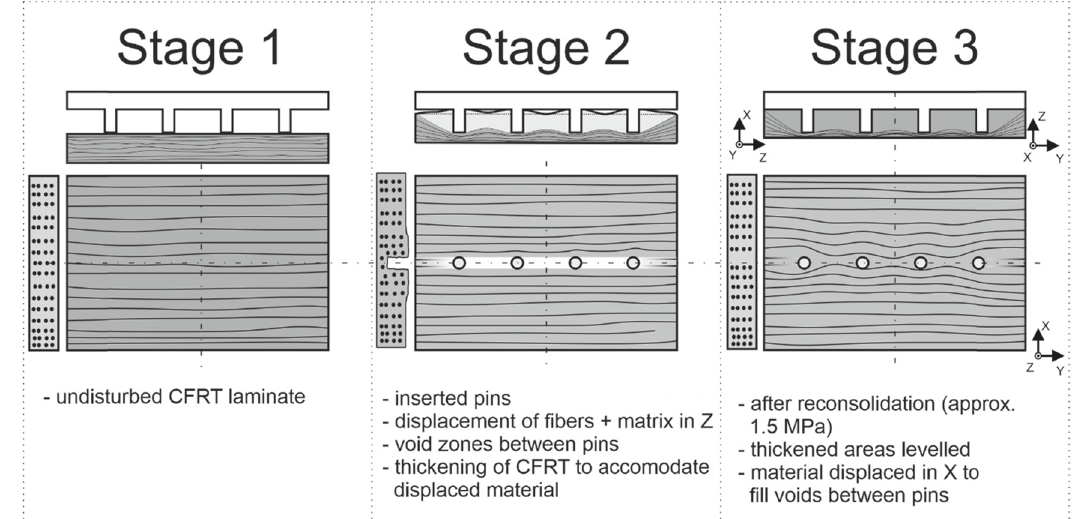
Figure 11: Model of fi ber